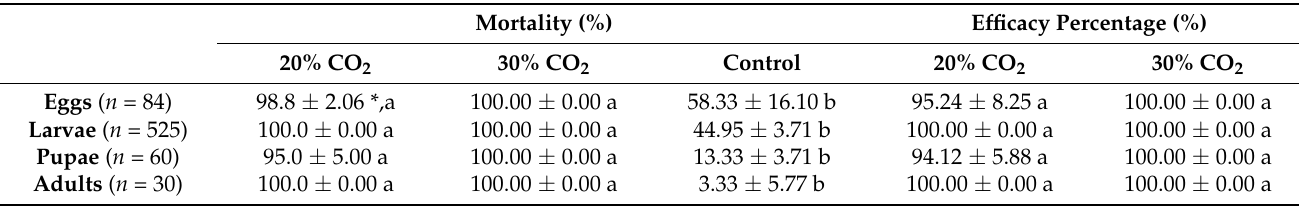
Table 1. Mortality and percentage of efficacy when Tecia solanivora in different life stages was exposed to 20 or 30% carbon dioxide-controlled atmospheres at 20 ◦ C.